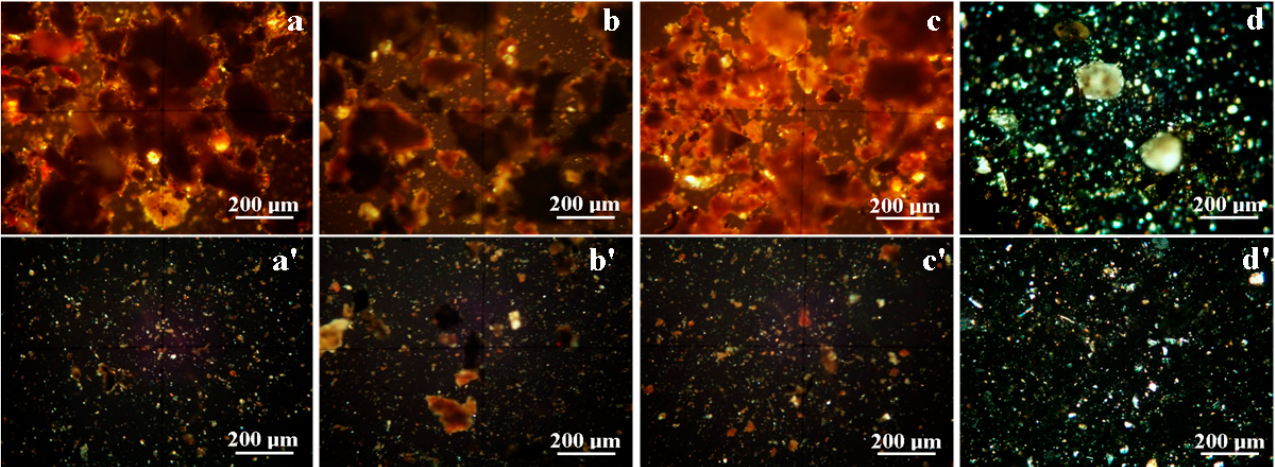
Figure 3. Optical mineralogical microscopy with cross-polarized light for large particlefraction: ( a ) Sample1, ( b ) Sample 2, ( c ) Sample 3 and ( d ) resting soil; and for small particle fraction: ( a ′ ) Sample1, ( b ′ ) Sample 2, ( c ′ ) Sample 3 and ( d ′ ) resting soil.